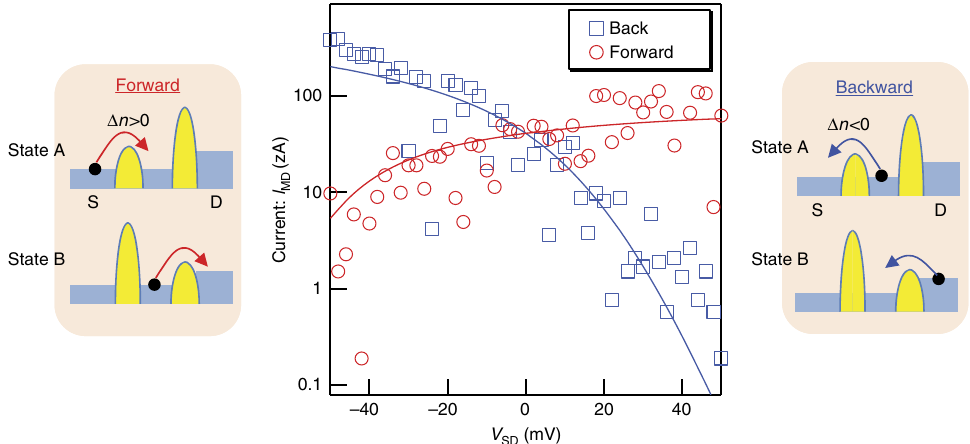
Figure 3 | Current generation by Maxwell’s demon as a function of the source–drain bias voltage V SD ( ¼ V S (cid:3) V D ). Open dots are experimental results. The solid lines are data obtained from Monte-Carlo simulation, whose details are explained in Supplementary Note 2. The two insets show schematics for forward current (drain-to-source current obtained with D n ¼ 2) and backward current (source-to-drain current obtained with D n ¼ (cid:3) 2) when negative V SD is applied. The reason the characteristics between forward and backward currents are asymmetric originates from the difference in the terminal from which electrons are supplied: In the forward direction, electrons are supplied from the S, whose chemical potential is fixed; in the backward direction, electrons are supplied from the D, whose chemical potential is varied by V SD . In the experiments, we applied V UG ¼ 3.1V, V G1 ¼ (cid:3) 2.4V and V G2 ¼ (cid:3) 1.95V for state A; V UG ¼ 2.7V, V G1 ¼ (cid:3) 3V and V G2 ¼ (cid:3) 1.6V for state B; V ED ¼ 1V, V S ¼ (cid:3) 0.6V for the both